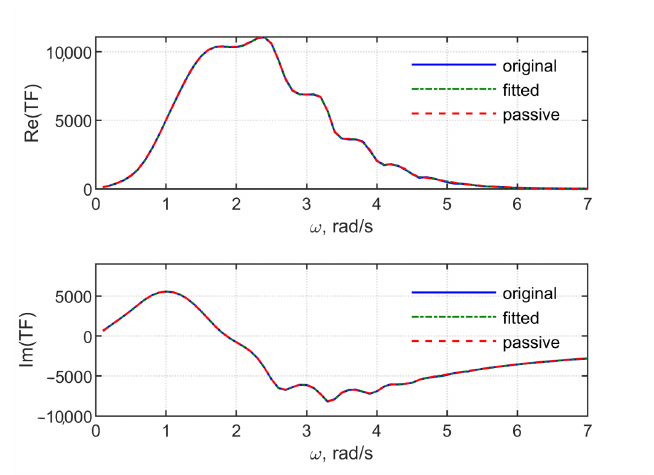
Figure 8. Approximation of transfer function using RAVF for the 2 m radius buoy. The fitting order is 16, the passivity condition was fulfilled.